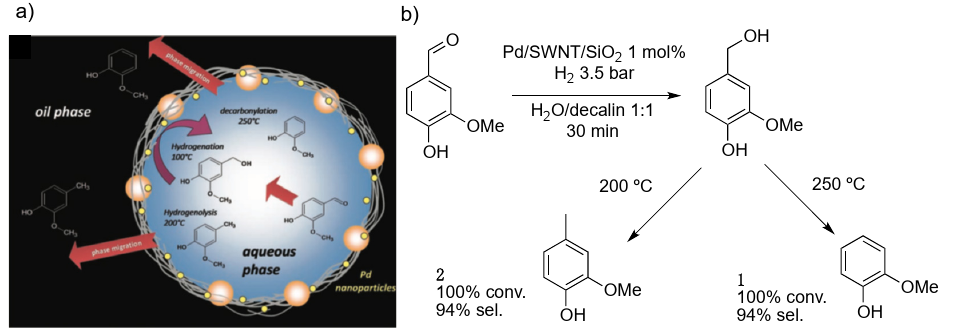
Figure 5. Schematic representation of the reaction at the water/oil interface in the solid stabilized emulsion ( a ). Hydrodeoxygenation reaction over Pd/SWNT/SiO 2 ( b ) [63]. Reproduced from [63] with permission from the American Association for the Advancement of Science.